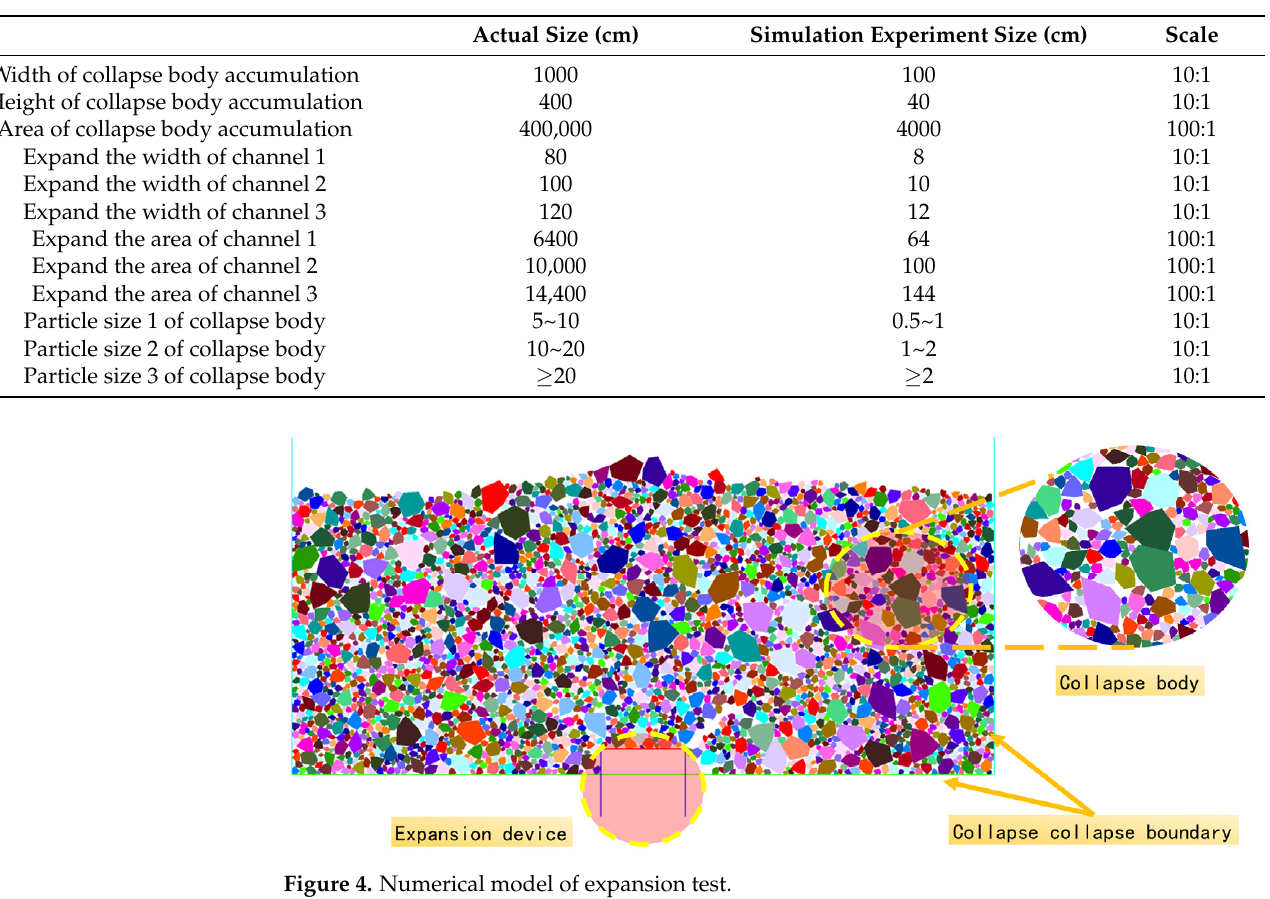
Table 1. Similarity ratio calculation.